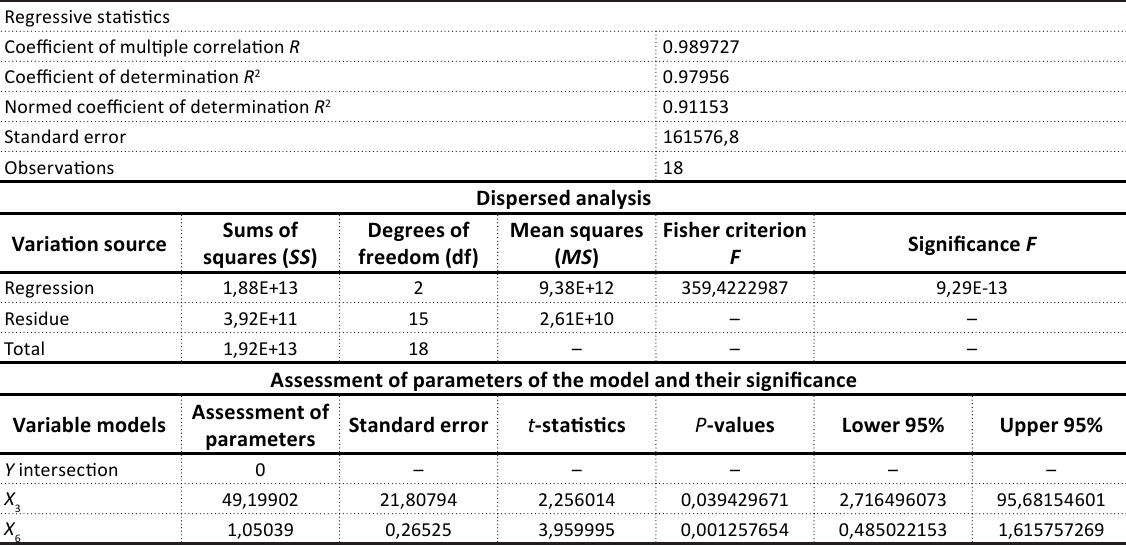
Table 3. Calculation